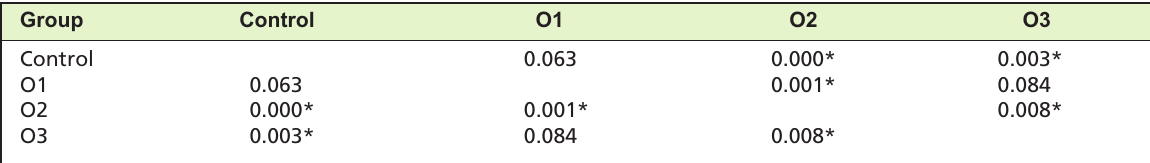
Comparative result between each O1, O2, O3, C Table III: